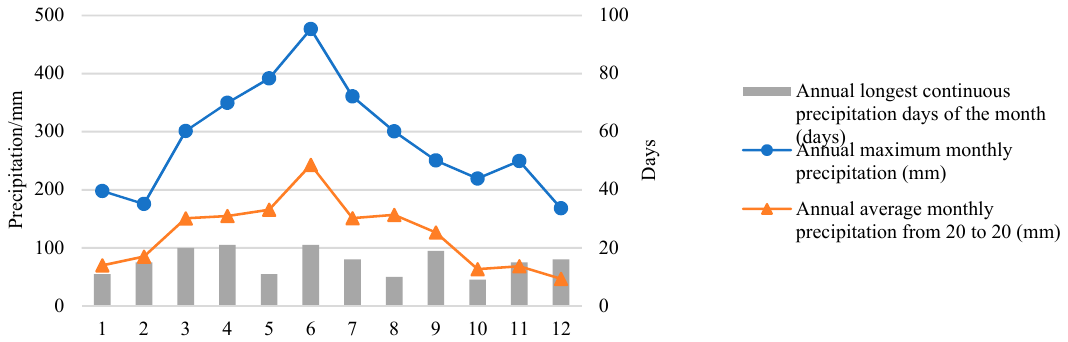
Figure 2. Monthly temperature and relative humidity (RH) in Jinyun County, Zhejiang Province, China.